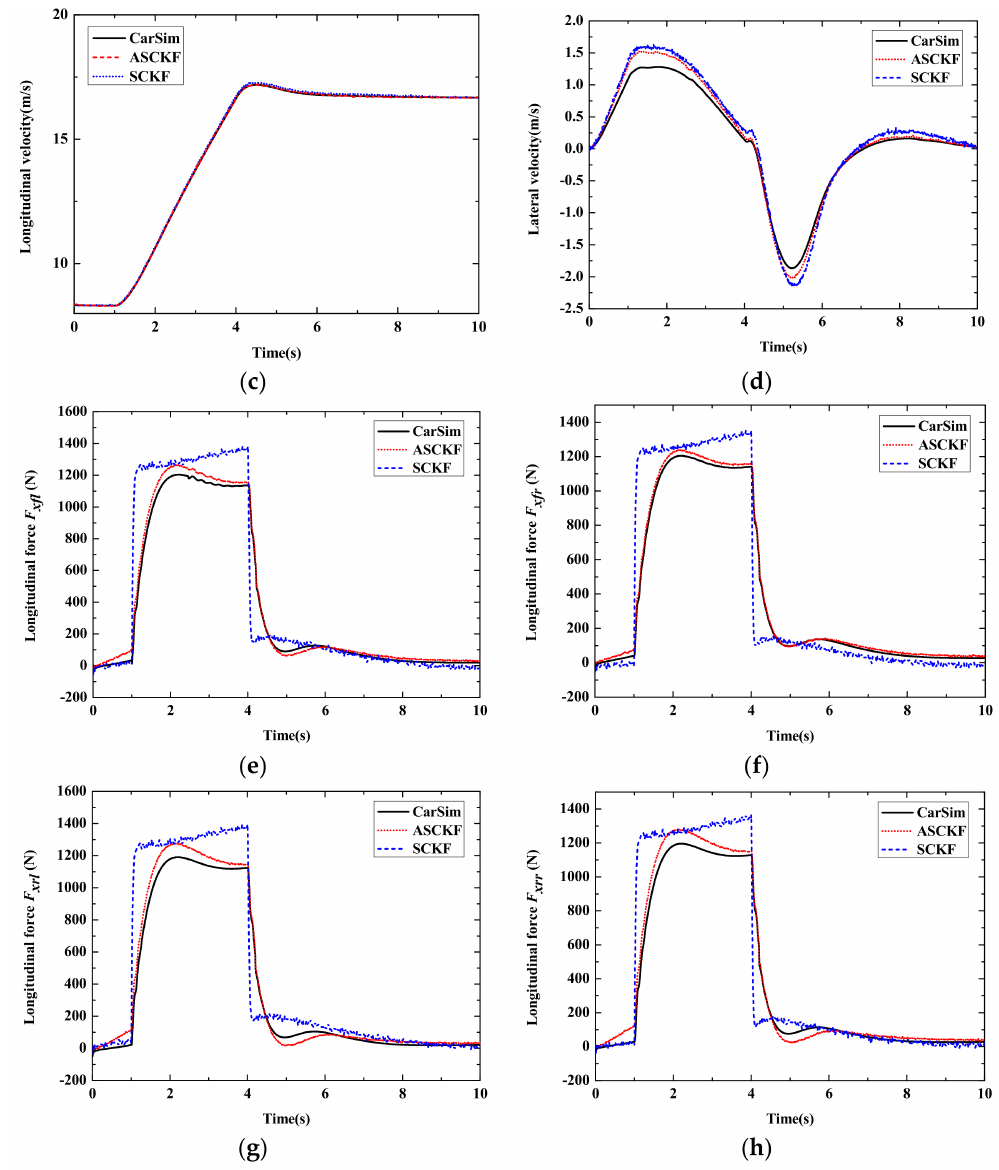
Figure 10. Simulation results of Case 2. ( a ) Yaw rate; ( b ) Sideslip angle; ( c ) Longitudinal vehicle speed; ( d ) Lateral vehicle speed; ( e ) Longitudinal force F fl ; ( f ) Longitudinal force F fr ; ( g ) Longitudinal force F rl ; ( h ) Longitudinal force F rr